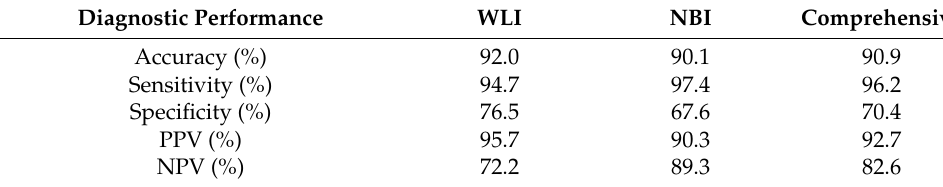
Table 2. Diagnostic performance of SSD for esophageal